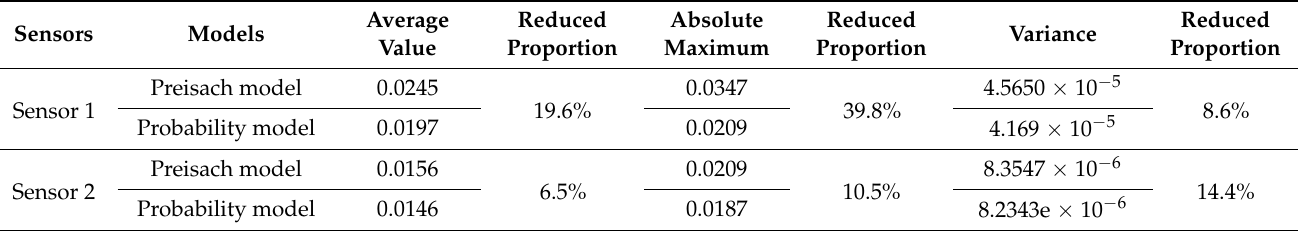
Figure 15. Errors of the second kind sensor.